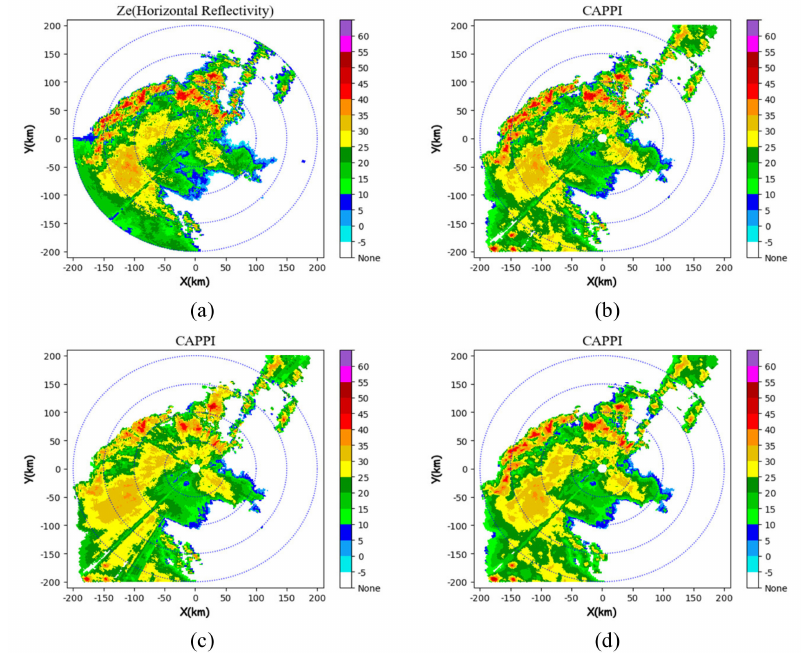
Figure 5. Interpolation results 1 (( a ) represents PPI; ( b ) represents NVI interpolation results; ( c ) repre- sents VHI interpolation results; ( d ) represents EPI interpolation